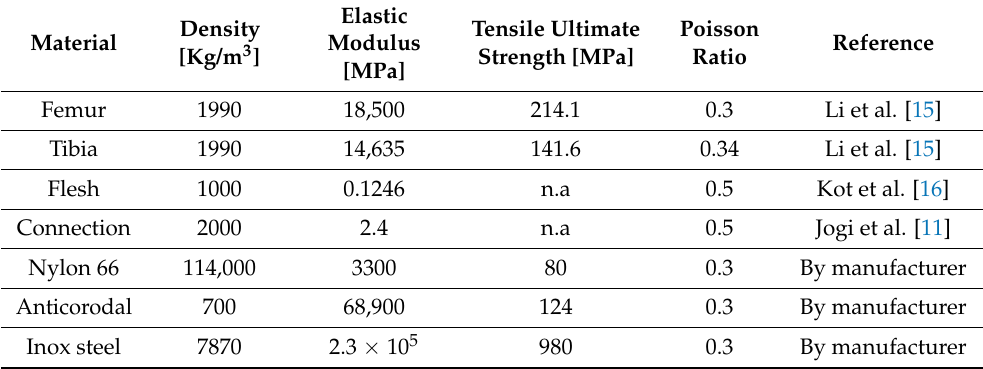
Table 1. Mechanical properties of FEA (limb, connection, and bracket